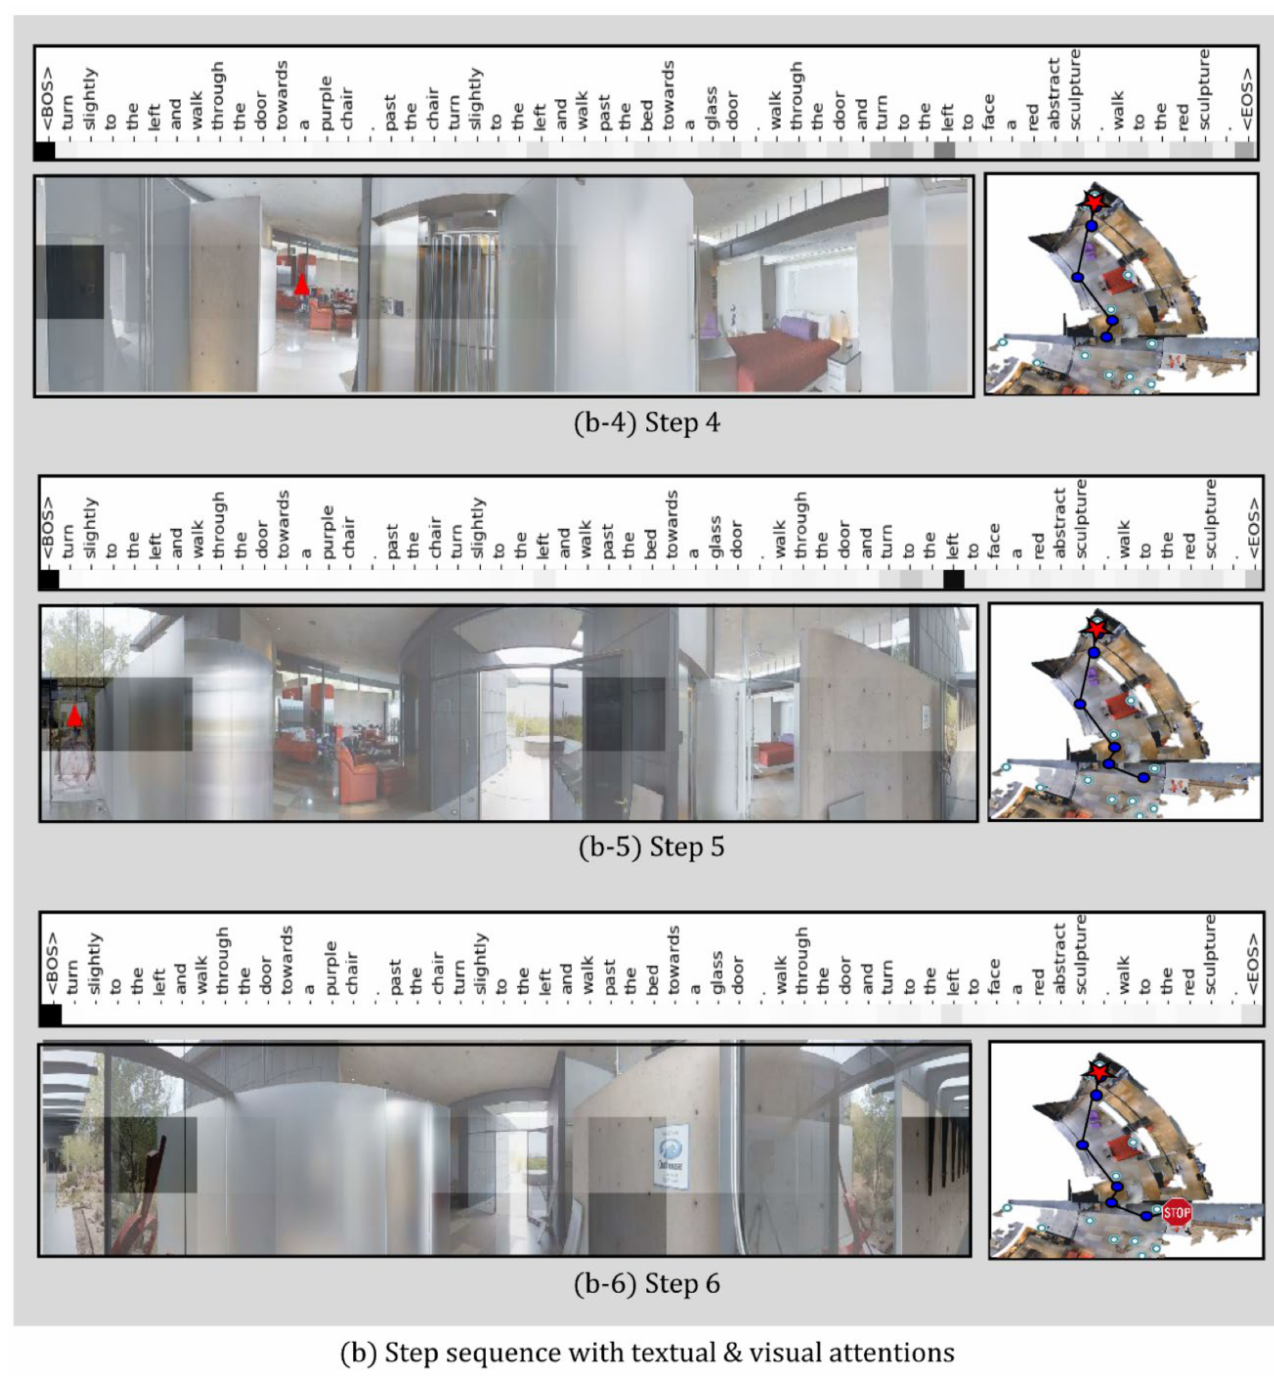
Figure 11. First example of VLN task executed by the proposed model JMEBS: Step